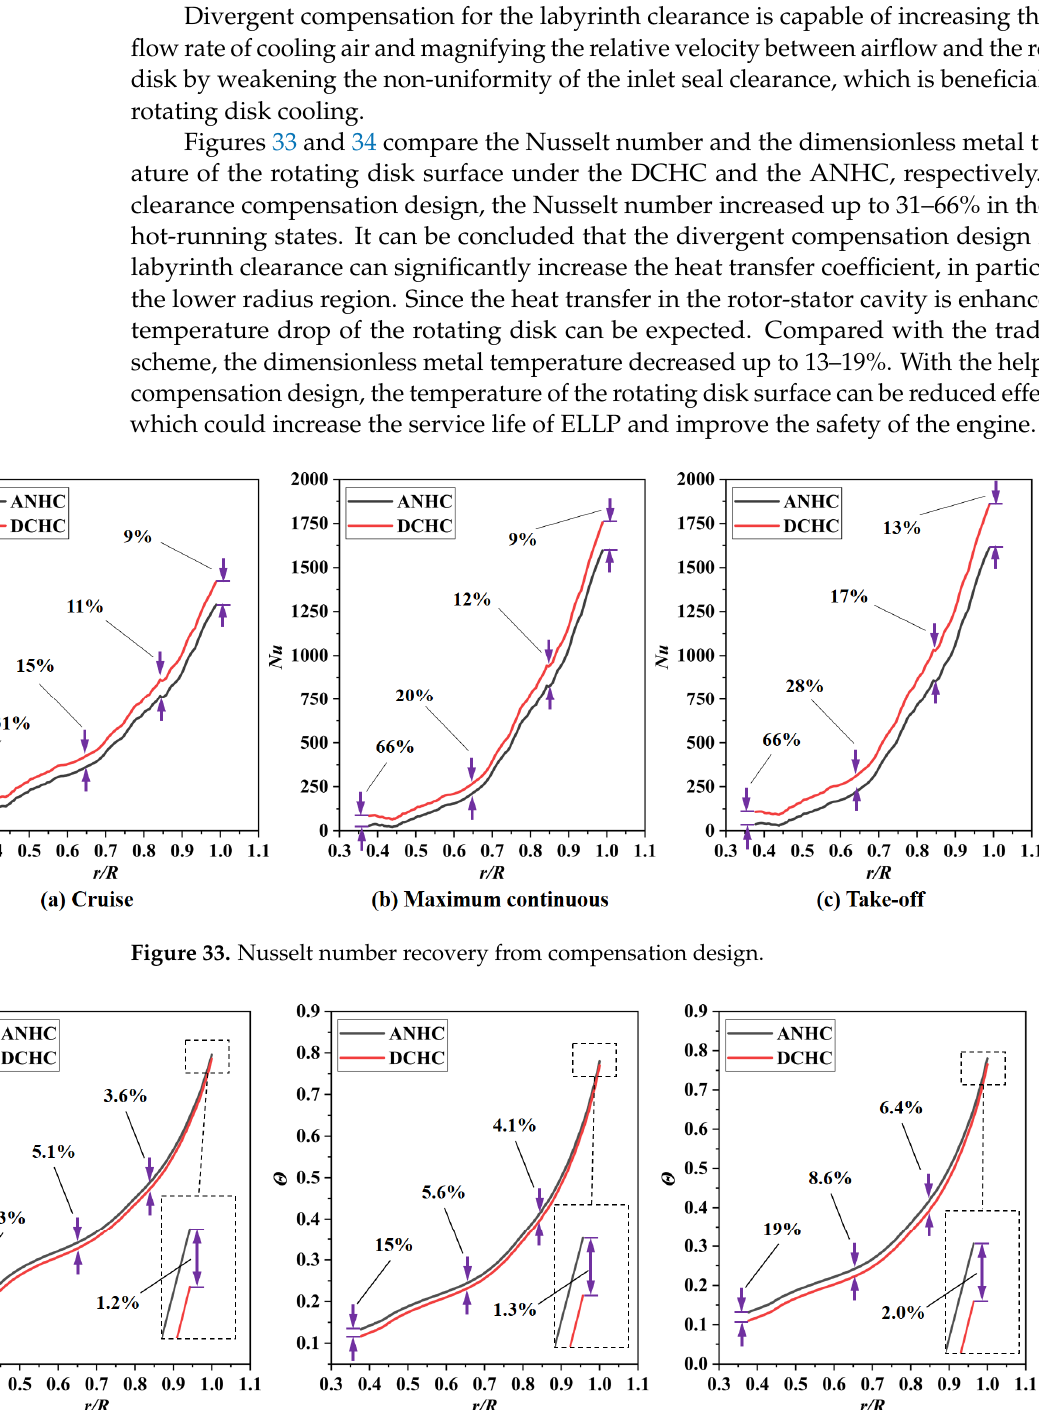
Figure 32. Moment coefficient of rotating disk surface under ANHC and DCHC.